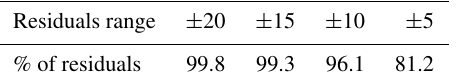
Table B10. Residuals